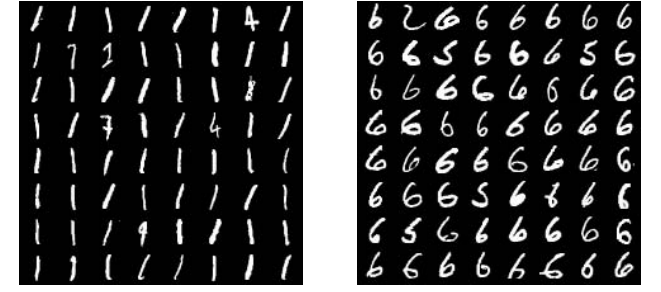
Figure 5. Cluster category